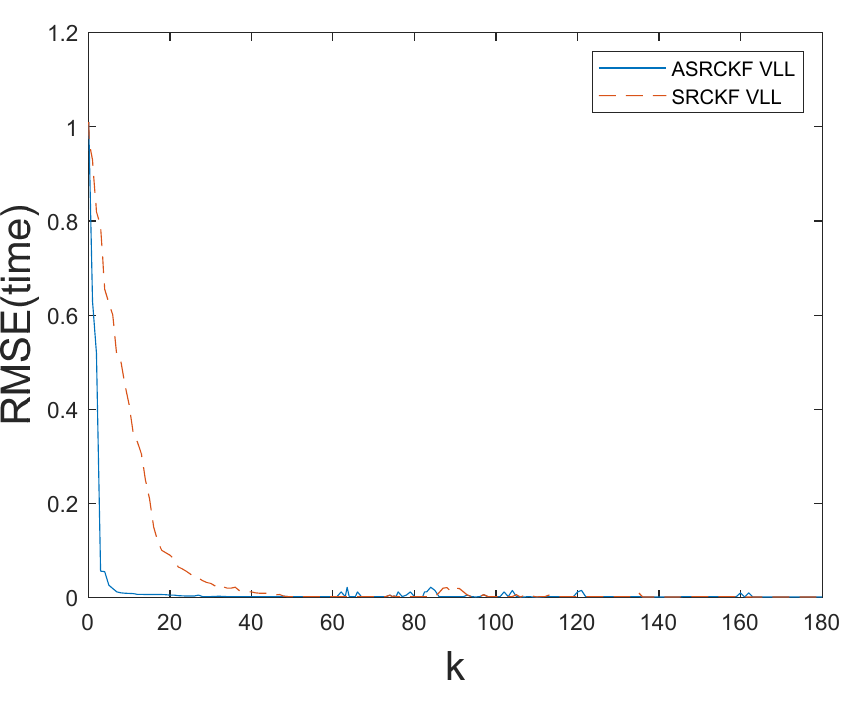
Figure 6. 𝑅𝑀𝑆𝐸 (cid:2930)(cid:2919)(cid:2923)(cid:2915) value when the filter uses the ASRCKF algorithm and the SRCKF algorithm Figure 6. RMSE time value when the filter uses the ASRCKF algorithm and the SRCKF algorithm to filter respectively and C/N 0 = 30 to filter respectively and C/N 0 = 30 dB-Hz.